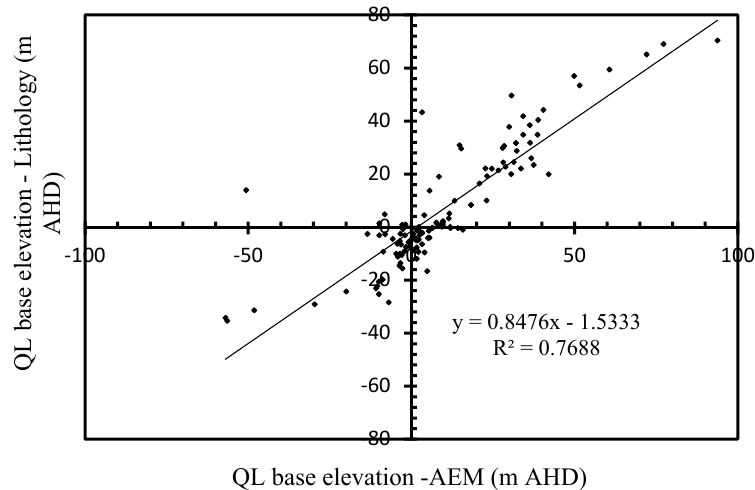
Figure 2. QL base elevations—Lithology vs. AEM.